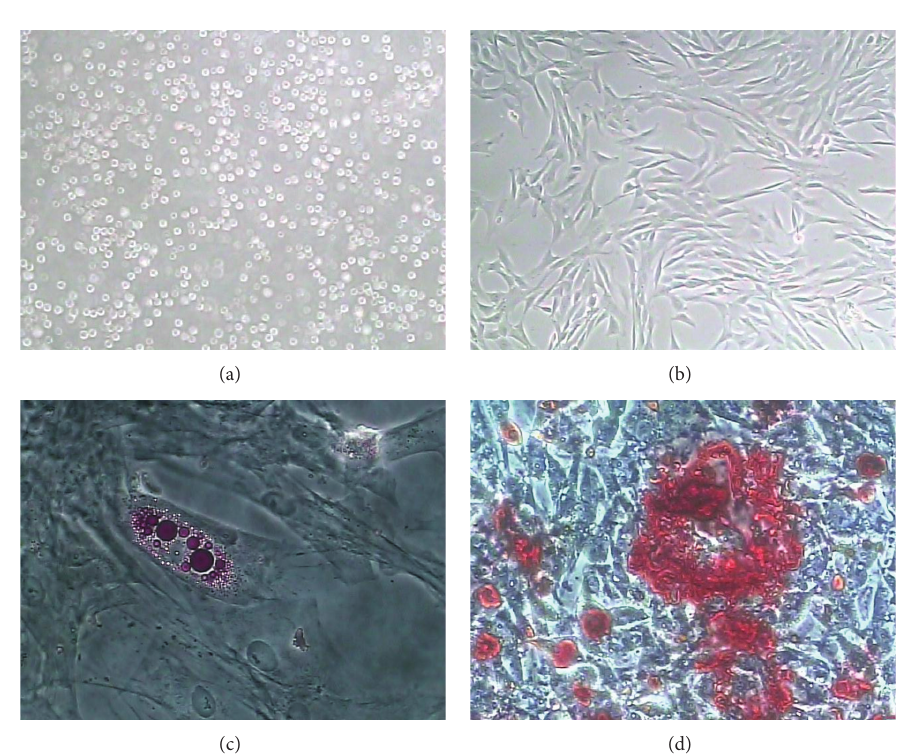
Figure 2: Collection, culture, differentiation, and application of dog bone marrow mesenchymal stem cells (MSC), in dog 2. (a) and (b) control cell cultures in noninducing medium. (a) Day one of a first passage culture. (b) Cell confluence after 15 days of culture. (c) Adipogenic differentiation; Oil red staining showing cytoplasmatic fat granuli inside cells. (d) Osteogenic differentiation. Alizarin red staining showing mineralized matrix deposition within stem cells. Magnification: (a) and (b) 100X; (c) and (d)